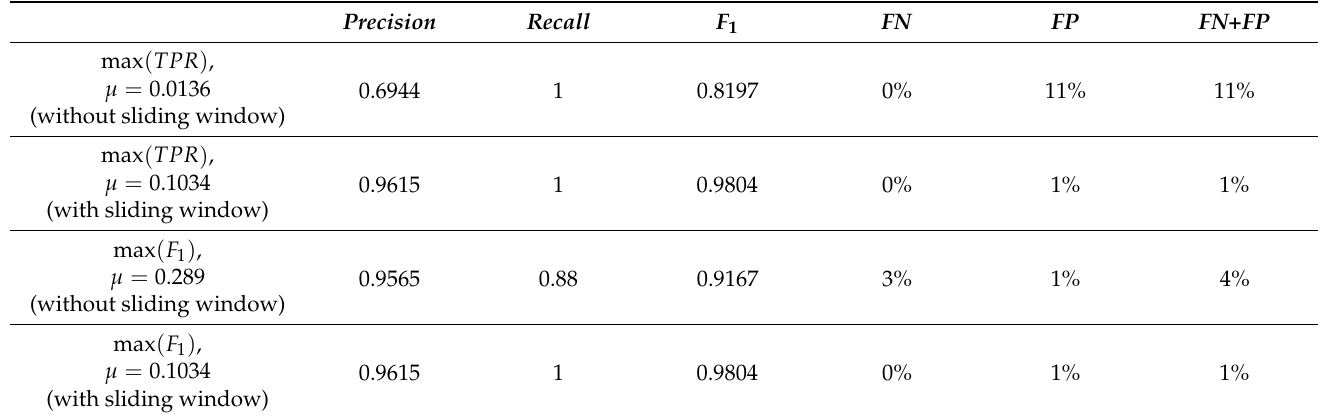
Table 4. The result of the two approaches for determining the threshold value for model predictions trained on data with and without a sliding